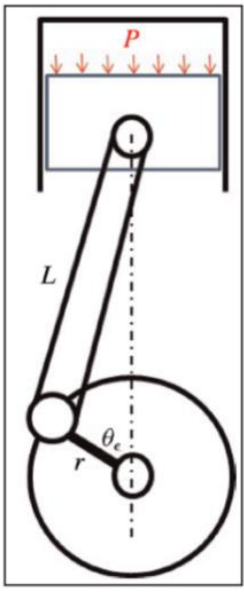
Figure 2. Schematic diagram of a single-cylinder mechanism [21].